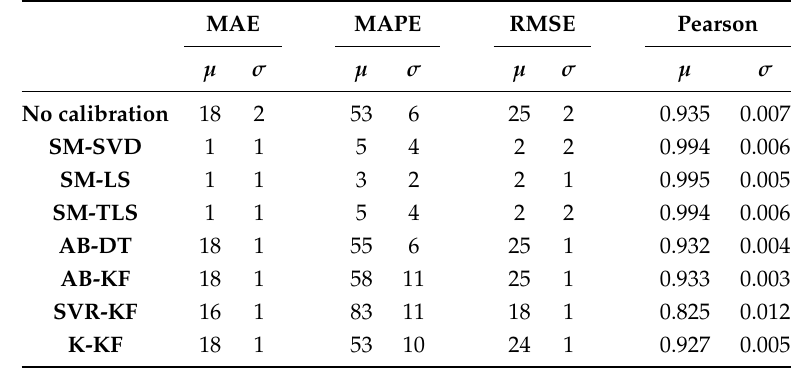
Table 1. Mean and standard deviation of each metric, computed on the entire time interval of drift, over the 16 nodes of the network. SM-(SVD, LS, TLS) strategies have the best results overall whatever the metric considered. SVR-KF provides corrected values only slightly better than before calibration according to MAE and RMSE but not according to MAPE and Pearson correlation coefficient. AB-(DT, KF) and K-KF do not improve the measured values significantly.